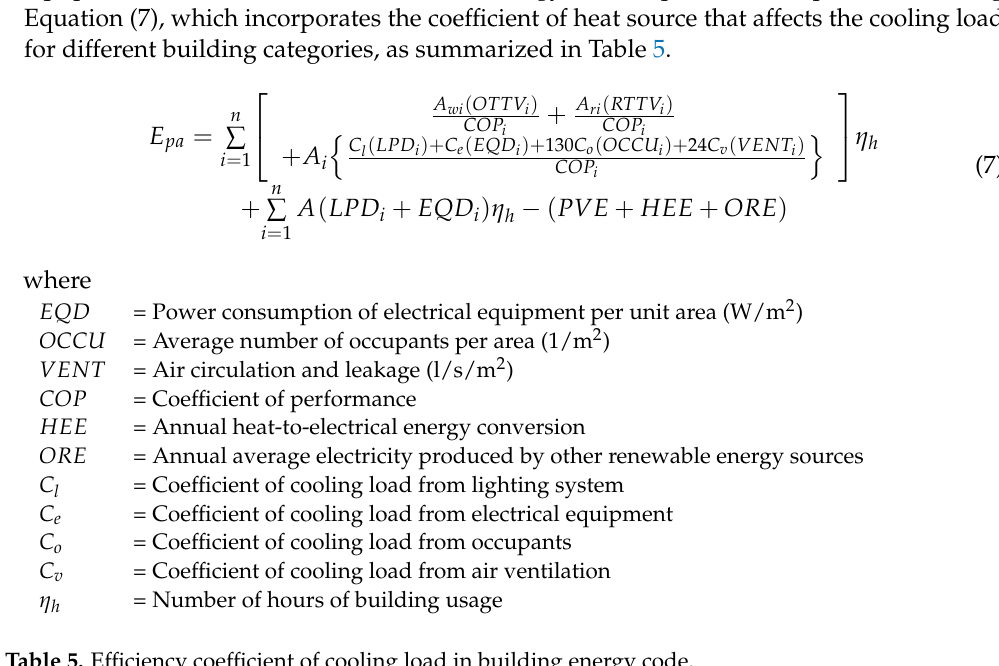
Table 5. Efficiency coefficient of cooling load in building energy